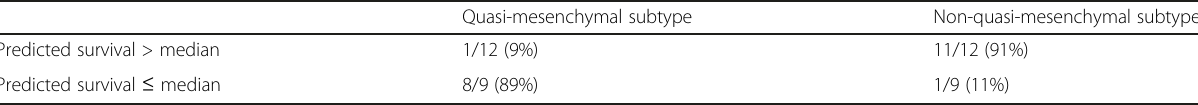
Table 2 Overlap between predicted survival groups and histopathological subtypes. The quasi-mesenchymal subtype was highly overrepresented in the group with predicted below-median survival, the non - quasi - mesenchymal subtypes in the group with predicted above-median survival ( n = 30 patients, p < 0.001, Fisher ’ s exact test) Quasi-mesenchymal